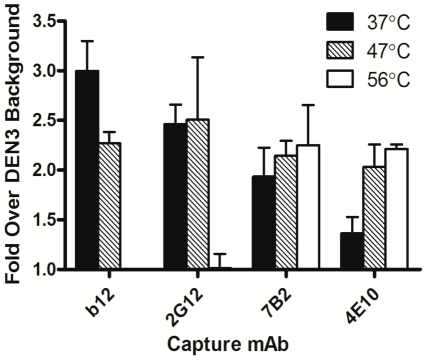
Effect of heat pre-treatment on mAb-virion capture efficiency.HIV-1LAI-JR-FL (MC) virions, produced in 293T cells, were incubated at the indicated temperatures for 1 h and anti-gp120 mAbs 2G12 (outer face), b12 (CD4 binding site), anti-gp41 mAbs 4E10 (MPER), and 7B2 (immunodominant loop), and the irrelevant mAb DEN3 were used to capture the heat treated virions in an in-solution virus capture assay. Amount of virion (p24) equivalents captured were determined using an in-house p24 ELISA and reported relative to background levels captured using DEN3.